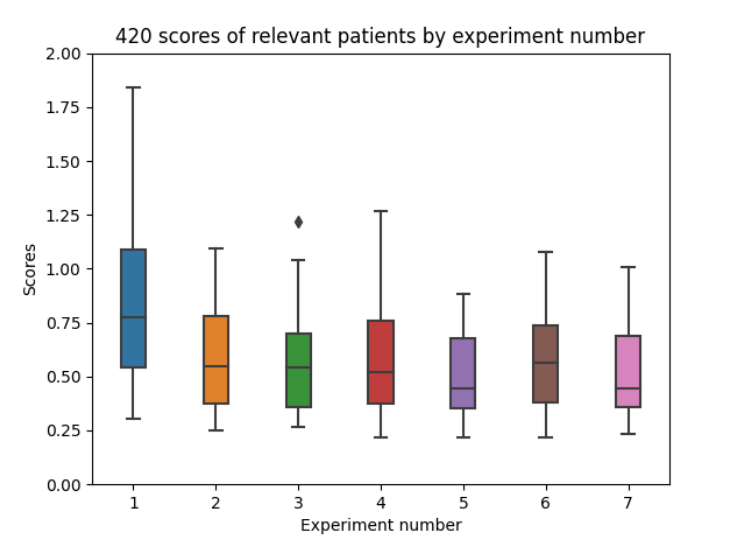
Figure 11. Experiments boxplot scores, from 10 executions for each patient and